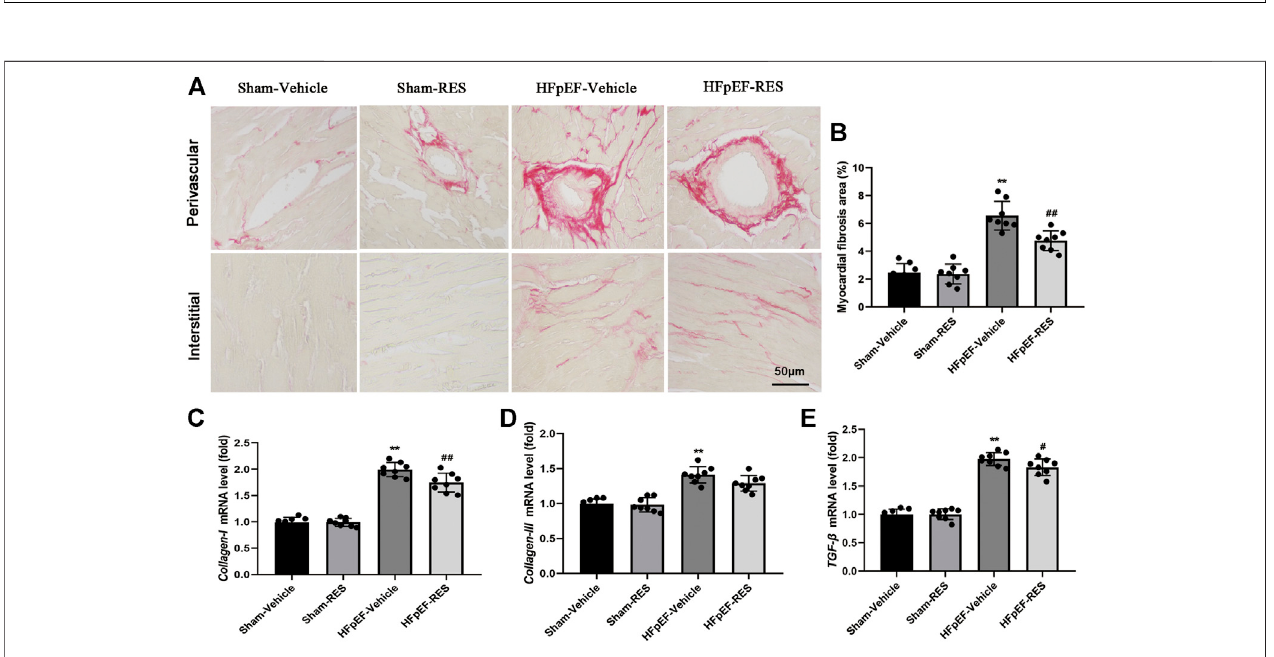
FIGURE6| EffectofRESonHFpEF-inducedcardiac fi brosis. (A) Representativeimagesofpicrosiriusred(PSR) – stainedheartsectionsand (B) quantitativeresults of fi brosis area. (C – E) Results of collagen-I and -III and TGF- β mRNA expressions ( n (cid:2) 8 per group). ** p < 0.01 vs. sham-vehicle group. # p < 0.05 vs. HFpEF-vehicle group. ## p < 0.01 vs. HFpEF-vehicle